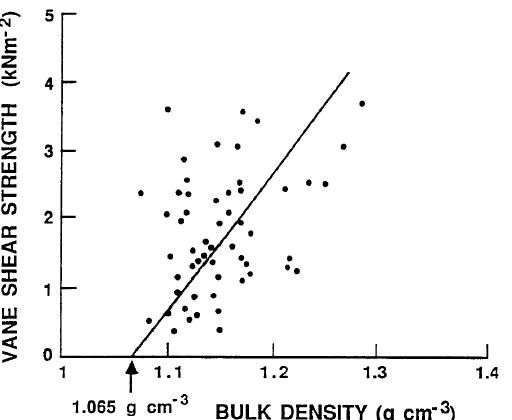
Figure 9. Mud vane shear strength variation with density. Redrawn from Hwang [36].